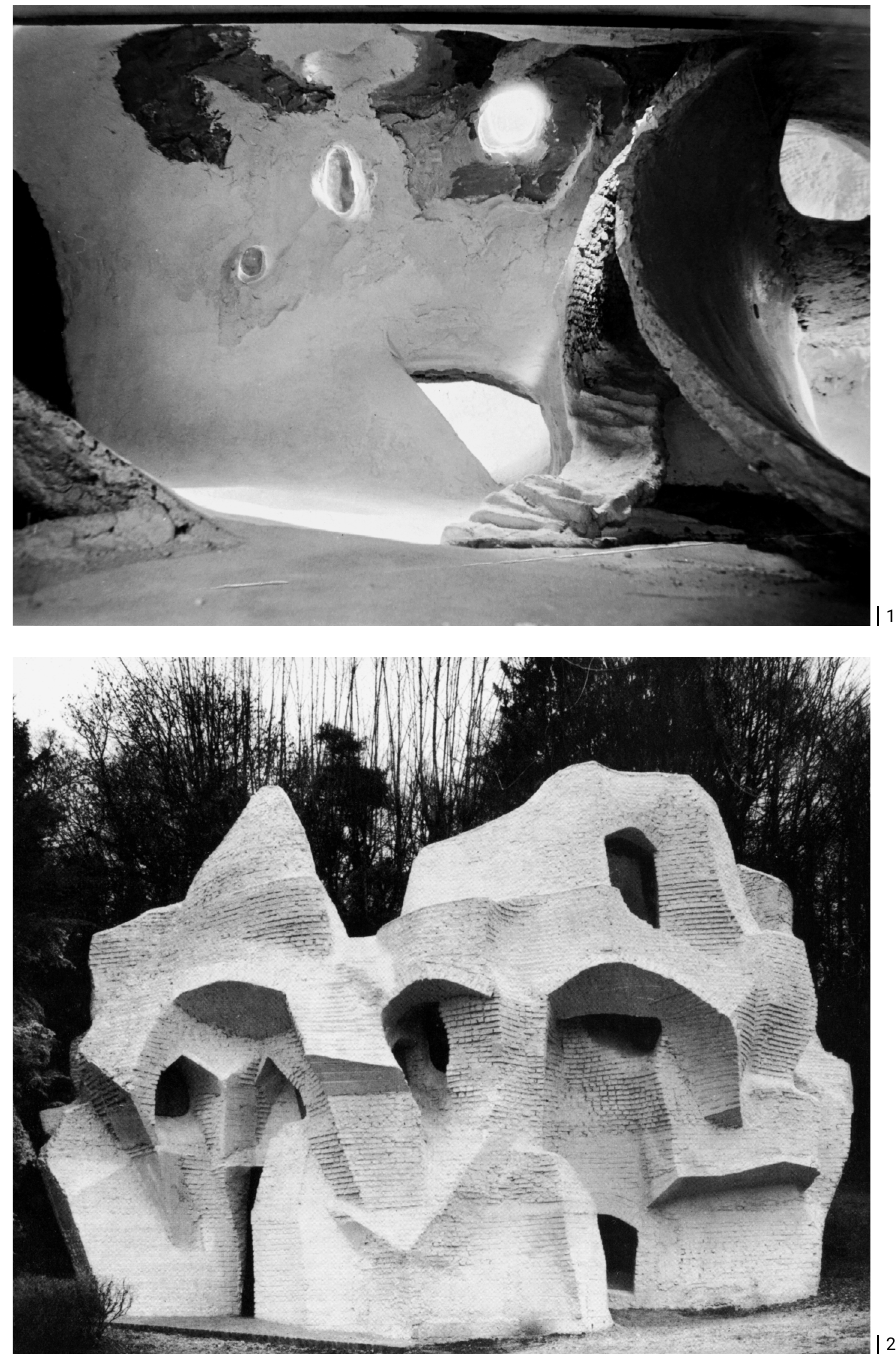
Photograph of the interior of Frederick Kiesler’s Endless House. The photograph, kept in Casa Studio Ricci, bears a MoMA stamp and the words ‘Visionary Architecture’ on the back. Casa Studio Ricci - Mon - terinaldi (FI). Fig. 20 Photograph of André Bloc’s Habitacle II, Meudon, 1964. From Bloc. Le monolithe frac- ture ,